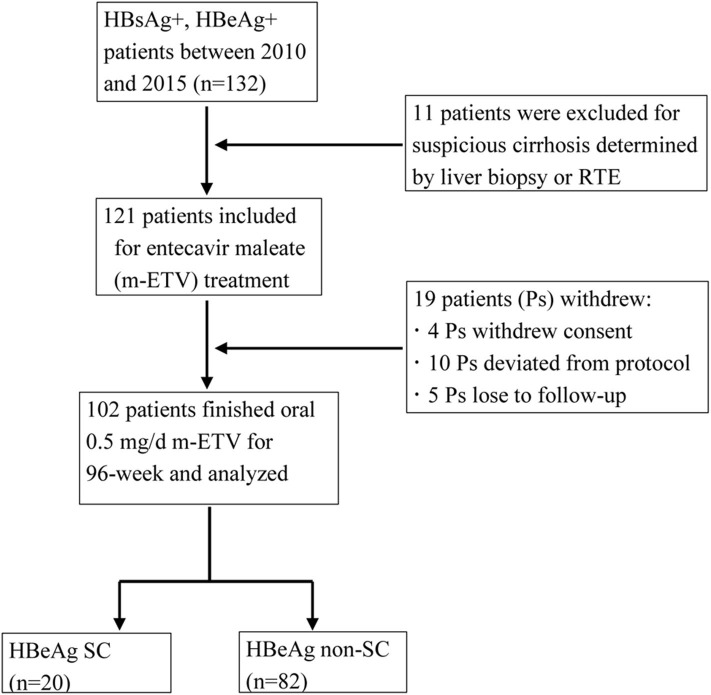
Flowchart of the CHB patients included in the study.